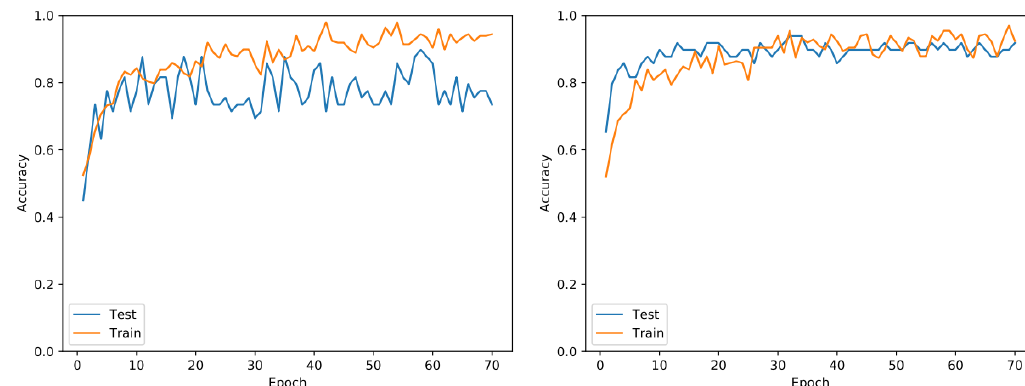
Figure 5. Learning curves for training and testing using the DenseNet architectecture, whose accuracy achieved the top results. Each plot corresponds to a five-fold split.